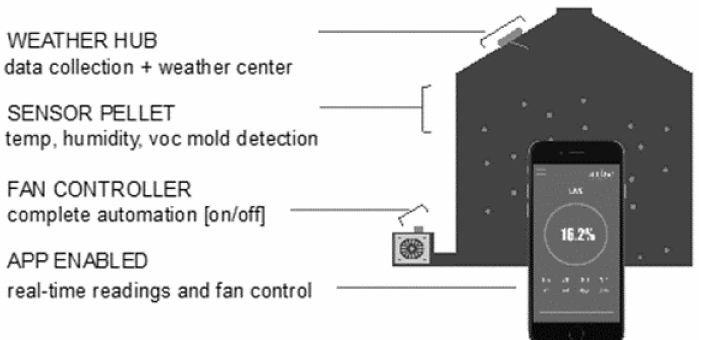
Figure 1. Schematic of Amber Agriculture wireless stored grain monitoring system utilizing wireless sensor “pellets” placed randomly within the grain mass reporting temperature and relative humidity values to a weather hub which records and sends data to an app-enabled device. Real-time readings can be used to make stored grain management decisions to manually or automatically control aeration